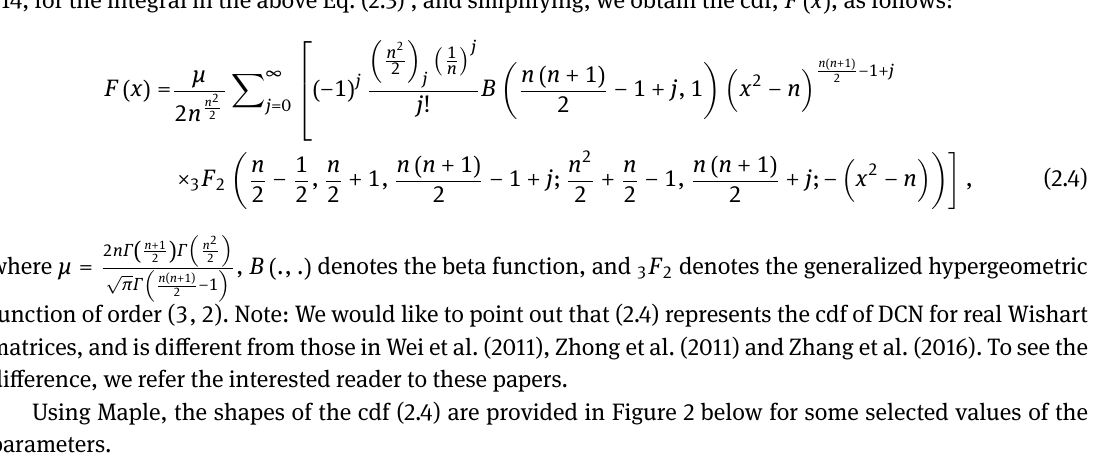
Figure 2: Plots of the cdf for n = 2 ,